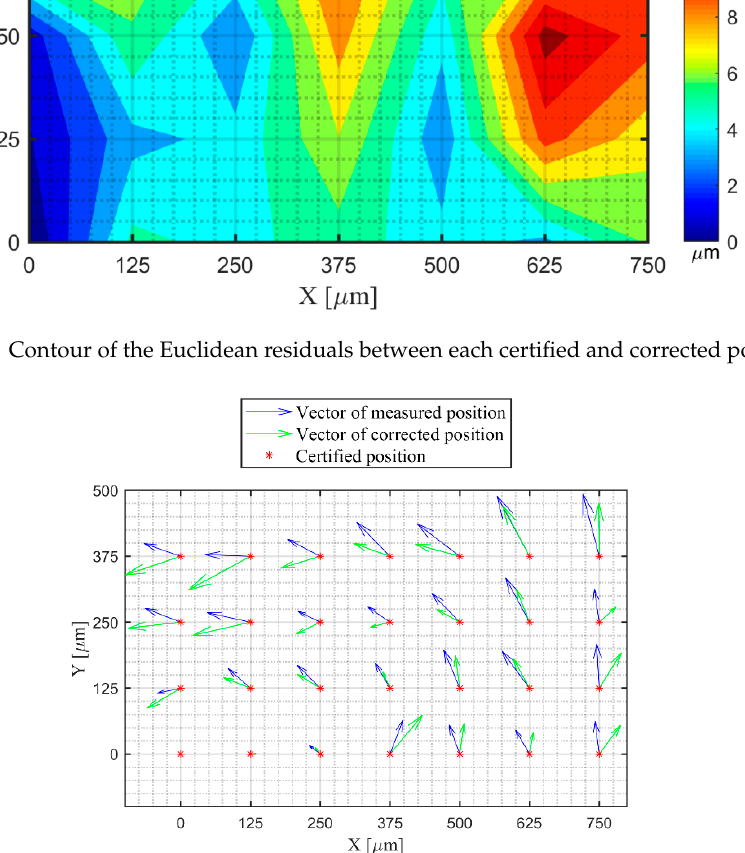
Figure 22. Comparison of the error vectors between the measured and corrected points.